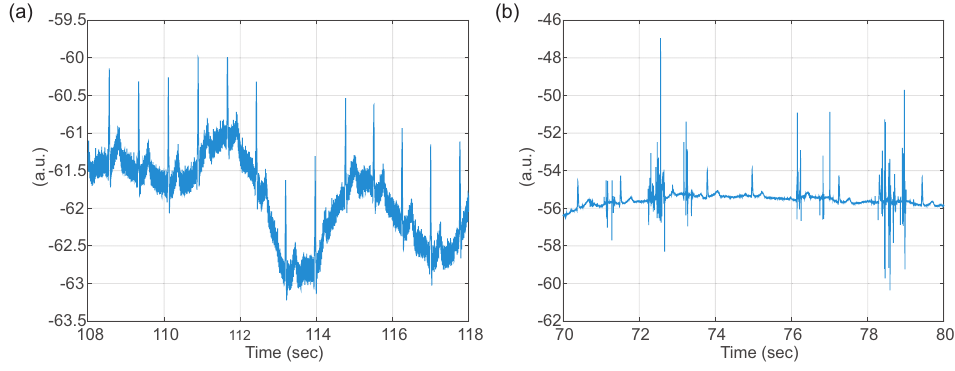
Figure 3. Raw unobtrusive ECG system (uECG) excerpts: ( a ) line noise and baseline wander (subject 5, lead aVF); ( b ) artifacts (subject 8, lead